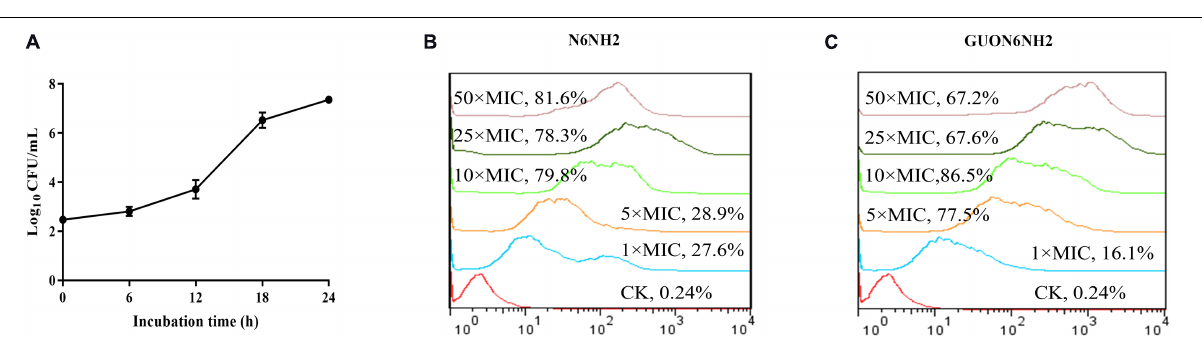
FIGURE 5 | Proliferation of E. tarda and internalization of N6NH2 and GUON6NH2 in RAW 264.7 cells. (A) Proliferation of E. tarda . RAW 264.7 cells were infected with E. tarda for 0.5 h, incubated with gentamicin, and lysed with 1% triton-X-100. The bacteria were counted at 0, 6, 12, 18, and 24 h, respectively. The results are given as the mean ± SEM ( n = 3). (B,C) FACS analysis of cellular internalization of FITC-labeled peptides in RAW 264.7 cells. The cells were incubated for 18 h with 1–50 × MIC FITC-N6NH2 (B) and FITC-GUON6NH2 (C) for 18 h at 37 ◦ C prior to washing and quantification of peptide uptake. The uptake of GUON6NH2 by macrophages is significantly greater than that of